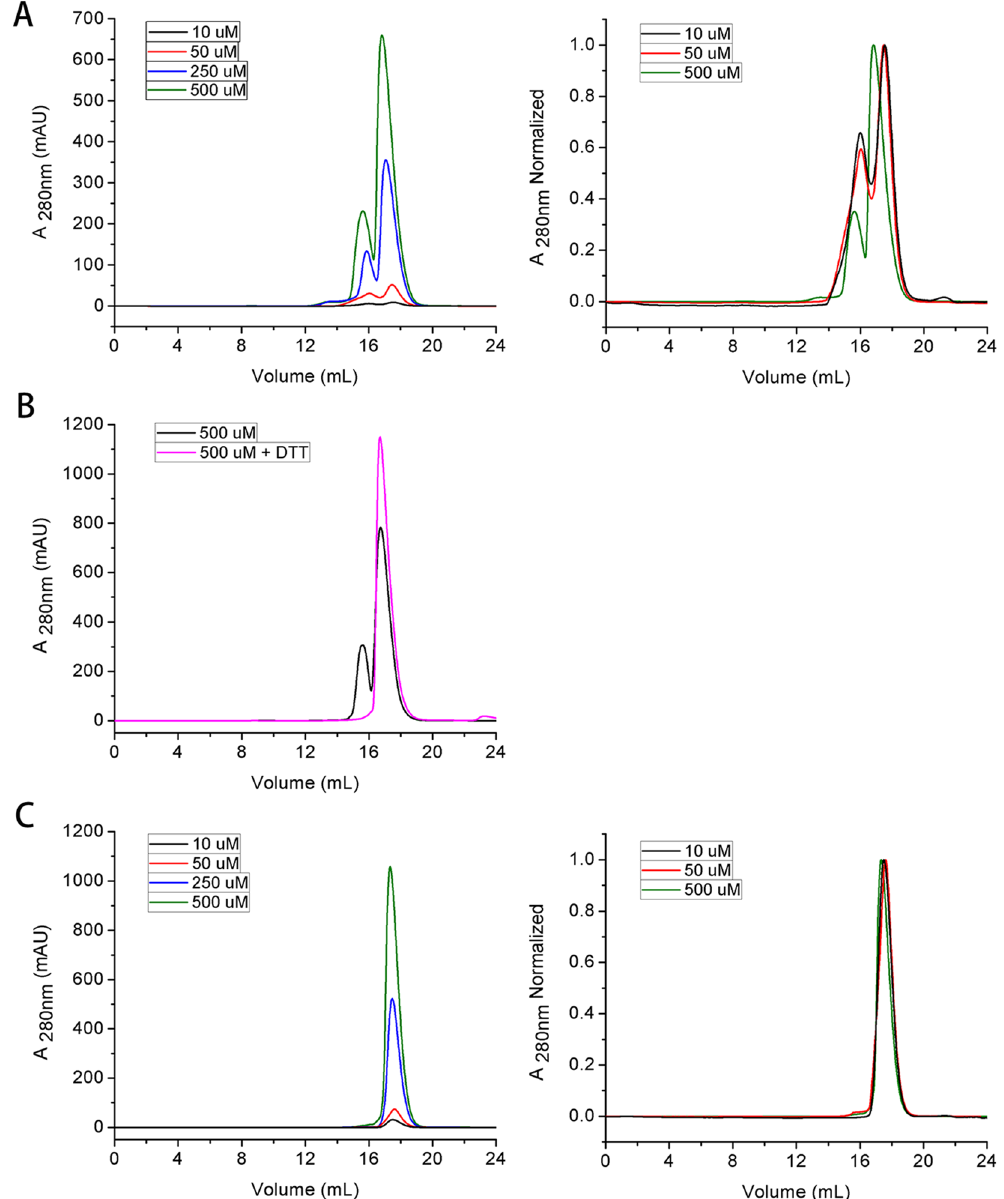
Figure 2. SEC profiles for TDP(1–77) and its Cys mutant. ( A ) SEC profiles for TDP(1–77) at different concentrations. ( B ) SEC profiles for TDP(1–77) with (pink) or without 5 mM DTT (black). The protein concentration was to 500 µ M. ( C ) SEC profiles for TDP(1–77)-C39/C50S at different concentrations. The SEC experiments were carried out using a Superdex-200 Increase 10/30 GL column previously equilibrated with Buffer A. The right panels show the normalized